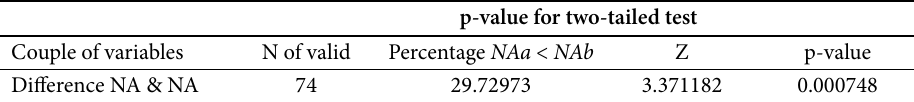
Table 11. The sign test for the category of small companies at p < 0.05 significance level p-value for two-tailed test Couple of variables N of valid Percentage NAa < NAb Z p-value Difference NA & NA 74 29.72973 3.371182